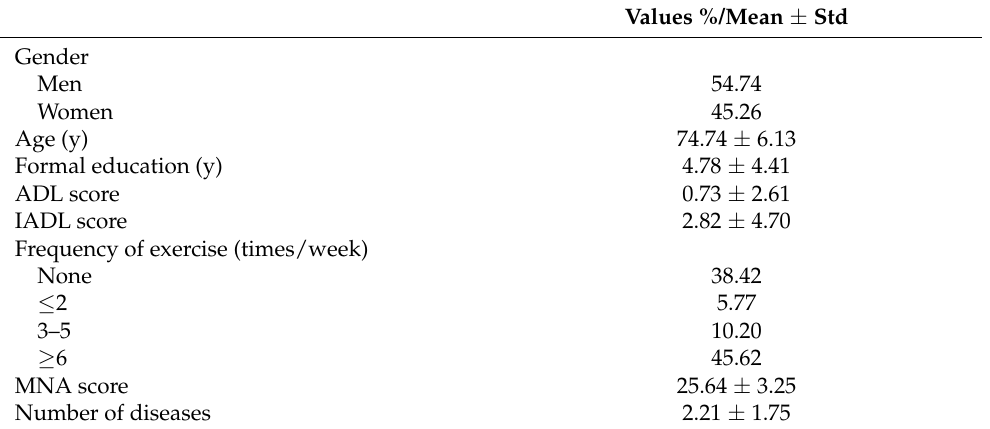
Table 1. Characteristics of study subjects in 1999 ( n = 2932).